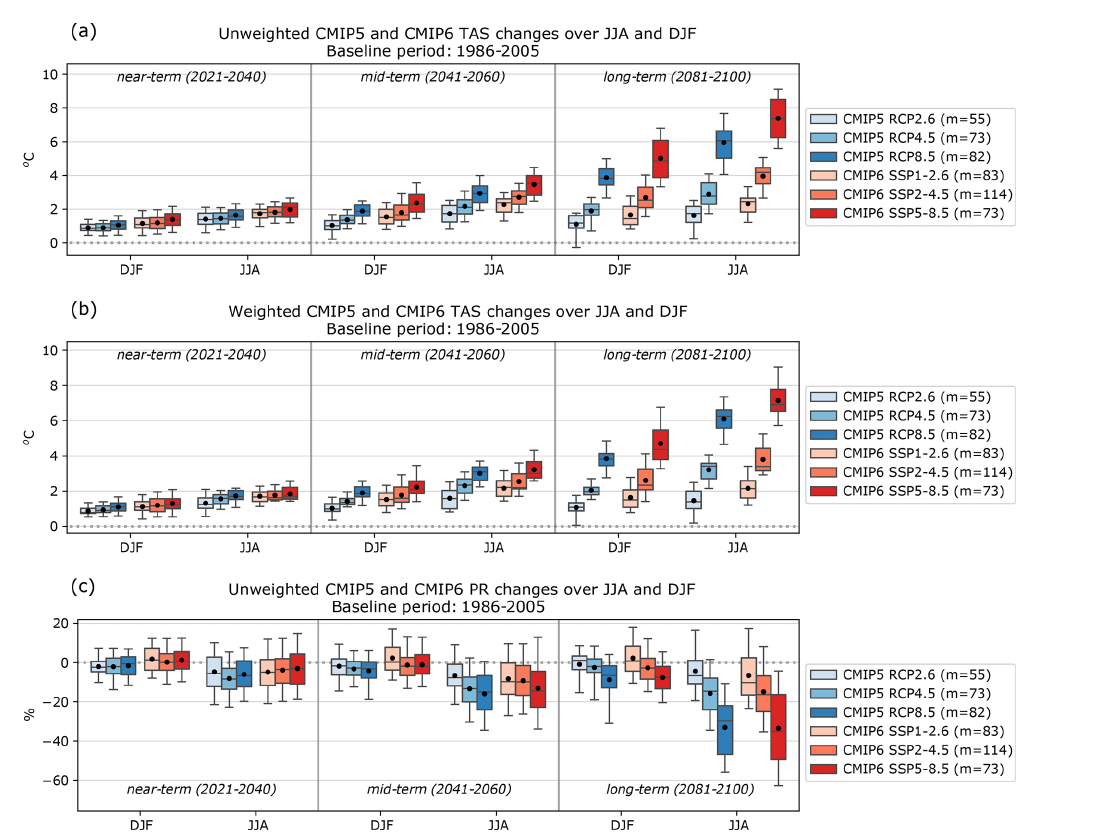
Figure 4. CMIP5 and CMIP6 JJA and DJF projections for the near-, mid- and long-term periods with respect to the baseline period consider- ing the 2.6, 4.5 and 8.5Wm − 2 RCP and SSP radiative forcing scenarios for (a) unweighted (cid:49) TAS, (b) weighted (cid:49) TAS and (c) unweighted (cid:49) PR. The black horizontal line in the boxes represents the median and the black dot is the mean. The interquartile range (IQR) and whiskers are defined by the 25th–75th and 5th–95th percentiles respectively. The number of members in the boxplot distributions is represented by m in the